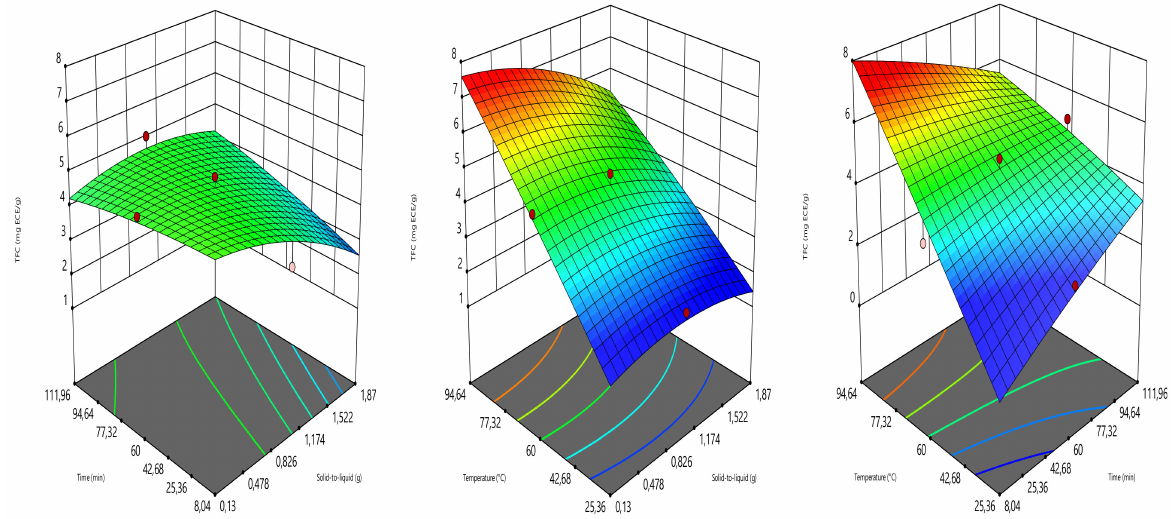
Figure 3. Three-dimensional graphics showing the effects of the independent variables on TFC. As can be seen in Figure 4, the temperature and decoction time have mostly influenced the response DPPH. The amount of this latter increased with the increase in the temperature and decoction time, while almost with solid-to-liquid ratio. Similarly, Nurraihana et al. [39] have reported that the DPPH values increased with the increase the extraction